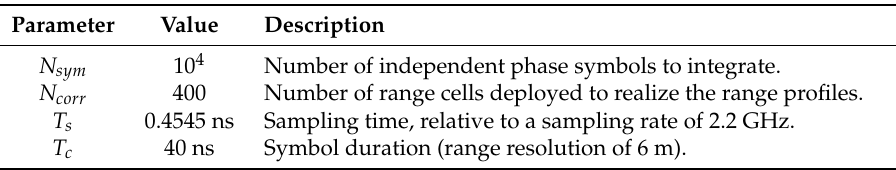
Table 3. Main parameters used in